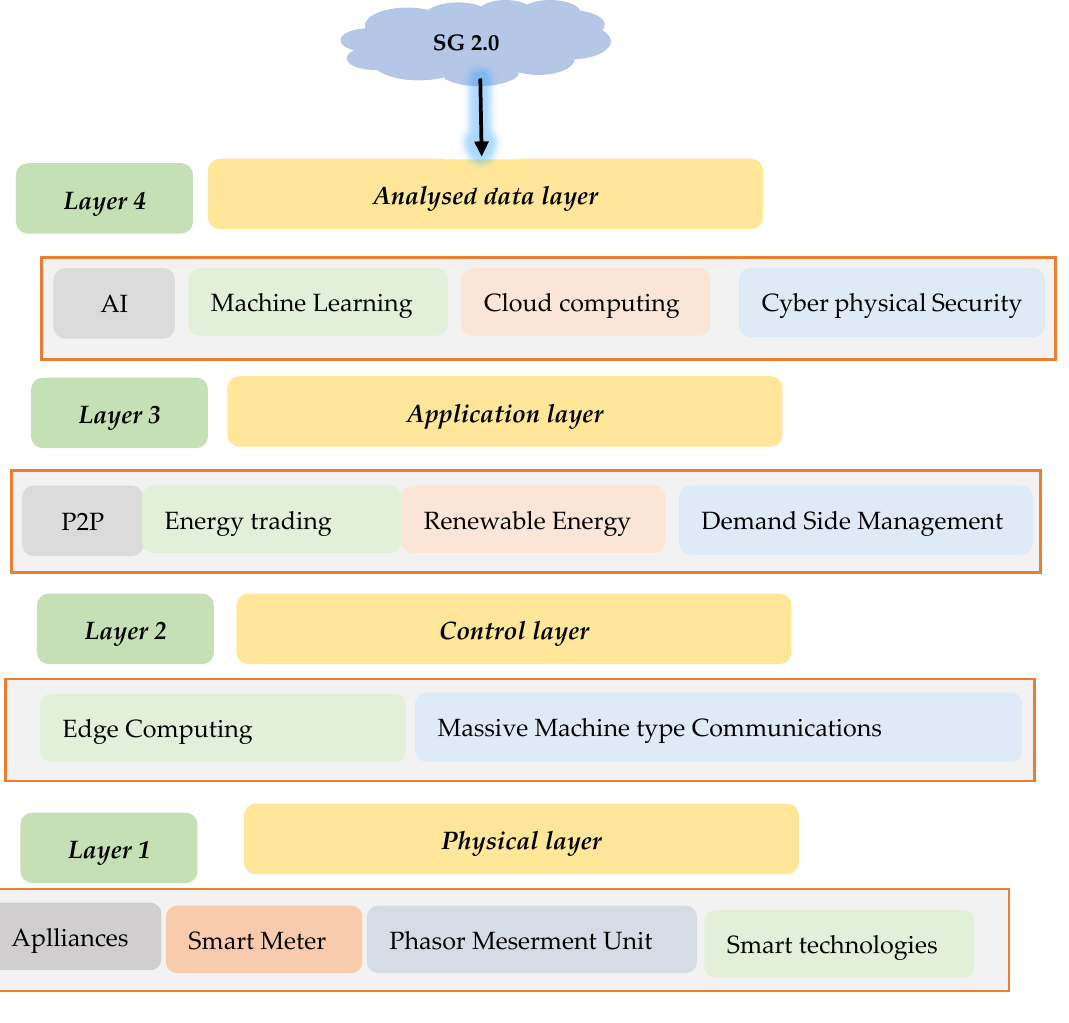
Figure 3. Smart Grid 2.0 Layers